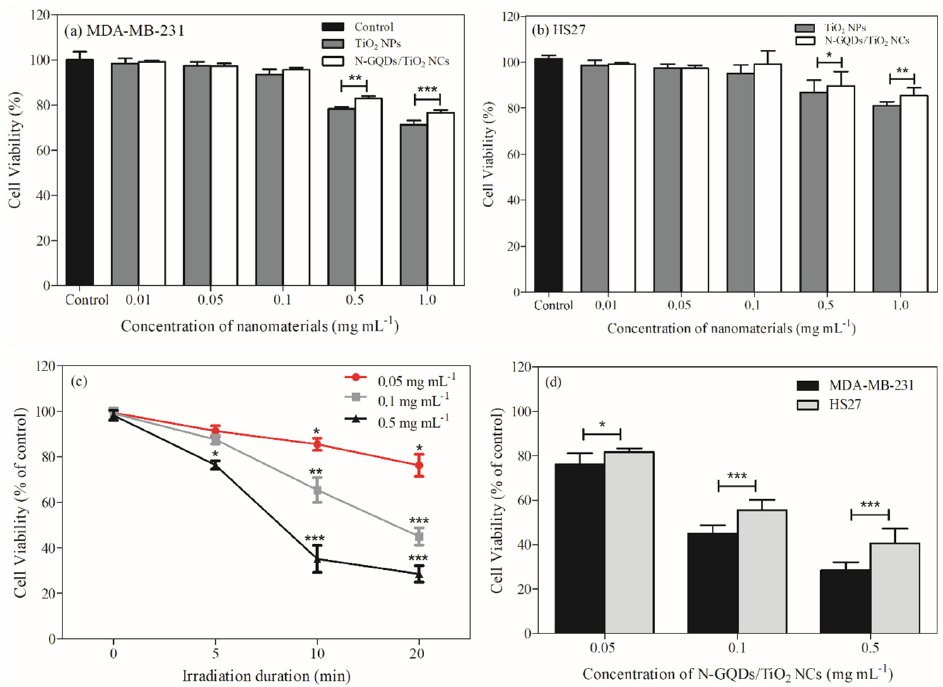
Figure 4. Cell viability of ( a ) MDA-MB-231 and ( b ) HS27 cells, ( c ) MDA-MB-231 cells treated with different concentrations of N-GQDs/TiO 2 NCs (0.05–0.5 mg mL − 1 ), then irradiated with various doses of NIR light (5–20 min) and ( d ) MDA-MB-231 and HS27 cells treated with different concentrations of N-GQDs/TiO 2 NCs (0.05–0.5 mg mL − 1 ), then irradiated with NIR light for 20 min. The cell viability was estimated at 24 h after irradiation. Data are presented as the mean ± SD of two inde-